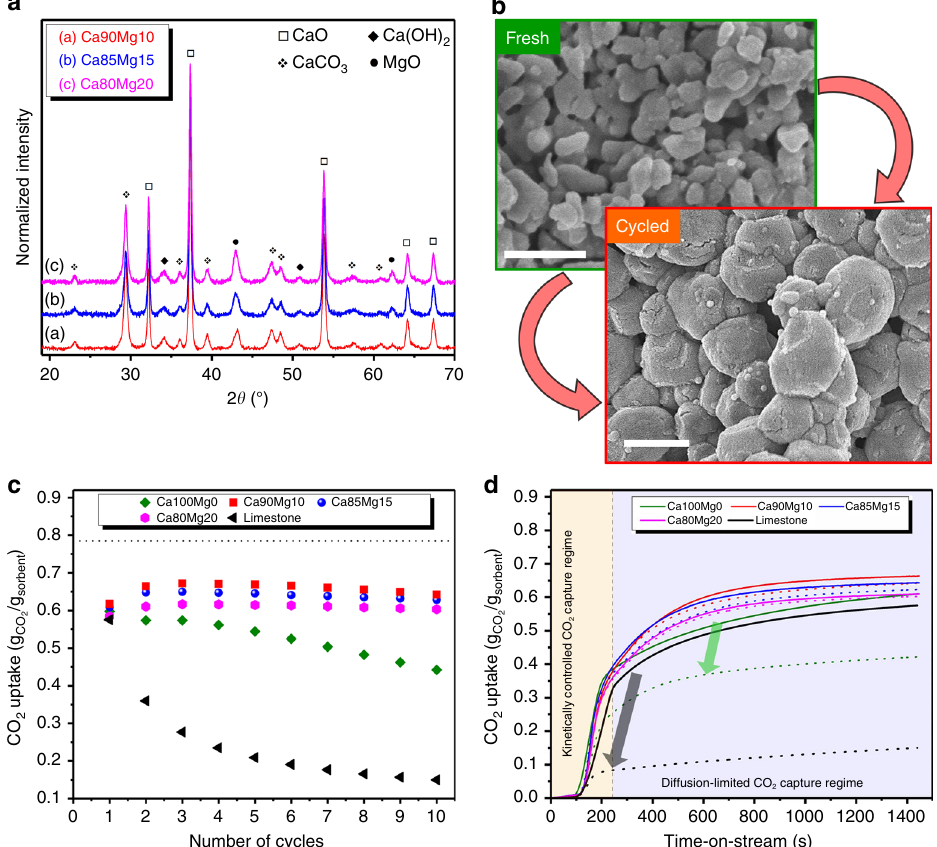
Fig. 4 Structure – performance relationship. a Powder XRD patterns of the sorbents synthesized after the removal of the carbonaceous template. b SEM images of the limestone-derived sorbent in the freshly calcined state and following ten operation cycles (scale bars: 400 nm). c CO 2 uptake of the hydrothermally synthesized CO 2 sorbents compared to limestone-derived CaO under harsh operating conditions (carbonation at 650 °C, calcination at 900 °C) (dotted line represents the maximum theoretical CO 2 uptake of Ca100Mg0). d Temporally resolved CO 2 uptake pro fi les of the hydrothermally synthesized sorbents in the 1st (solid line) and 10th (dashed line) carbonation cycle NATURE COMMUNICATIONS| (2018) 9:2408 |DOI: